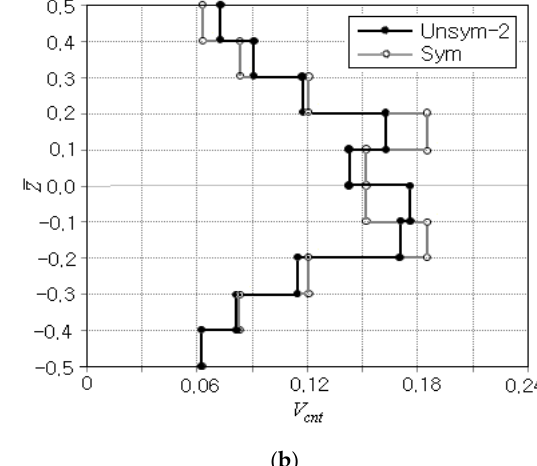
a ) unsym-1 , ( b ) unsym-2 cnt : (